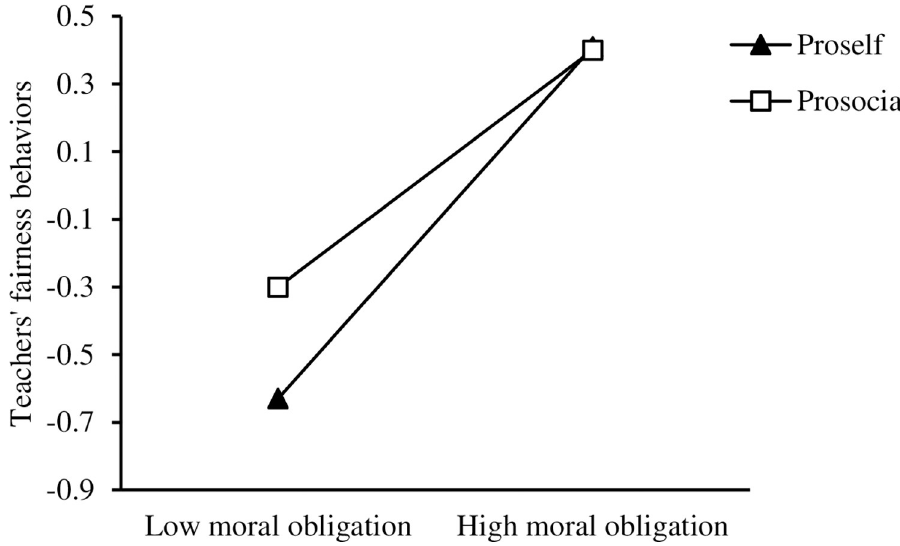
Fig 3. Interaction between moral obligation and social value orientation on teachers’ fairness